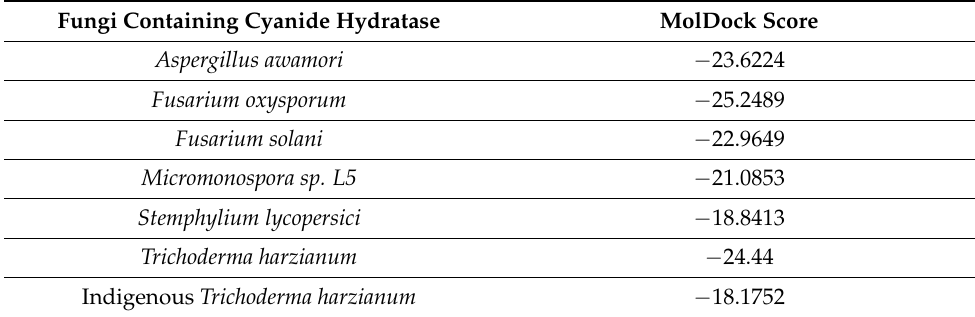
Figure 6. Structural validations of predicted mCHT model: ( A ) Ramachandran plot: as shown in the plot, 98.9% of residues are in the most favored and allowed regions, while 1.1% are within the disallowed region (3 residues). ( B ) Z-plot: Z-score of the model is shown as a black dot within the plot region, which is in the range of native model with the same size. ( C ) ERRAT evaluation plot showing the quality of model based on non-bond interactions. ERRAT quality score was calculated to be 75.2542. Table 1. Cyanide hydratase of different fungi and their MolDock score.